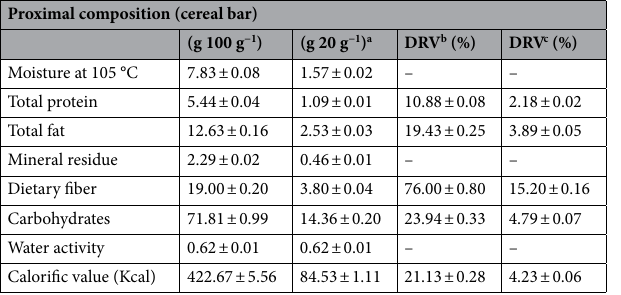
Table 3. Proximal and nutritional composition of the formulated cereal bar. DRV daily reference value based on a diet of 2000 kcal in Brazil. a Approximately weight of a cereal bar. b Portion of 100 g. c Portion of 20 g.